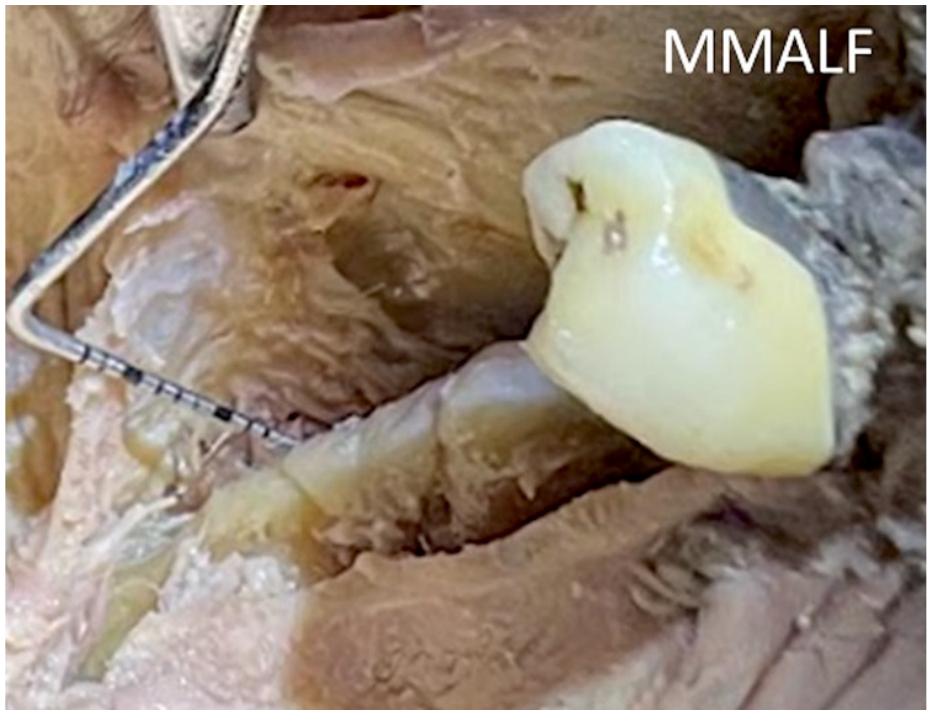
Figure 11. A human cadaver overview of a 23 mm release of the mylohyoid muscle using the MMALF technique.